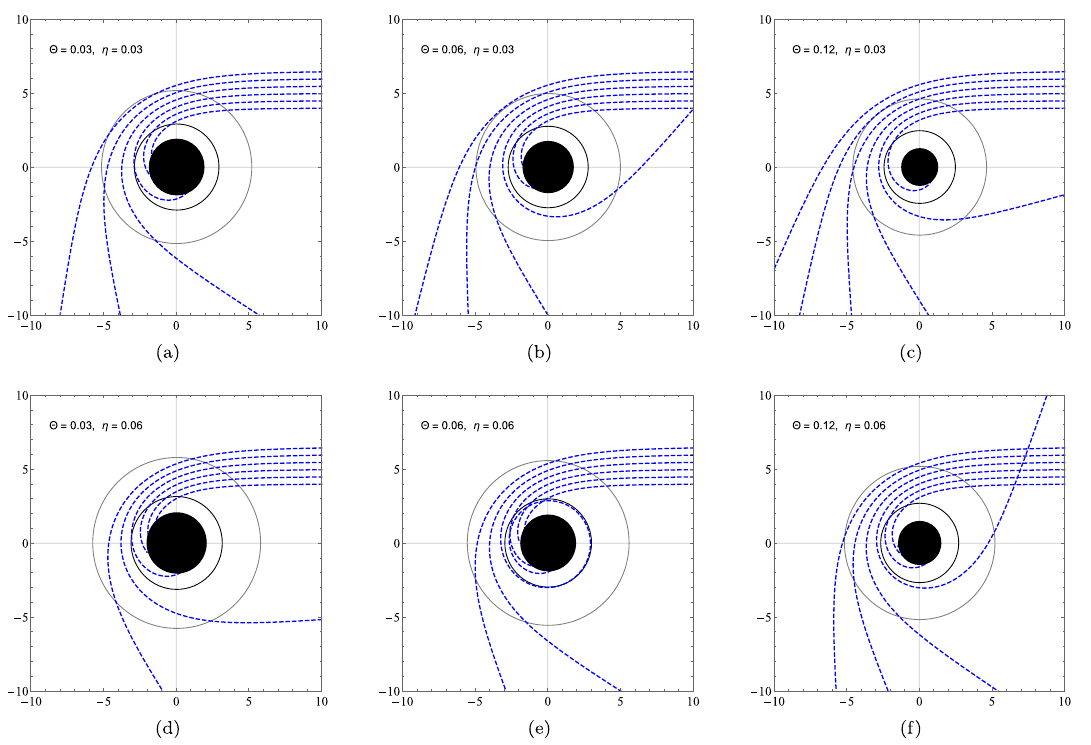
inner black ring is the criticalradius or the radius of the sphere of photos while the outer ring corresponds to the critical impact parameter